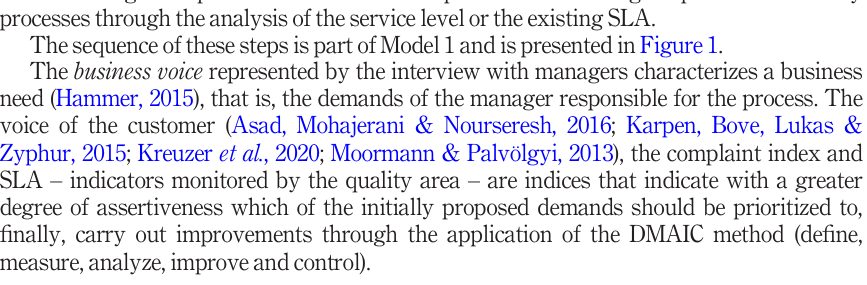
Figure 1. Model 1 process